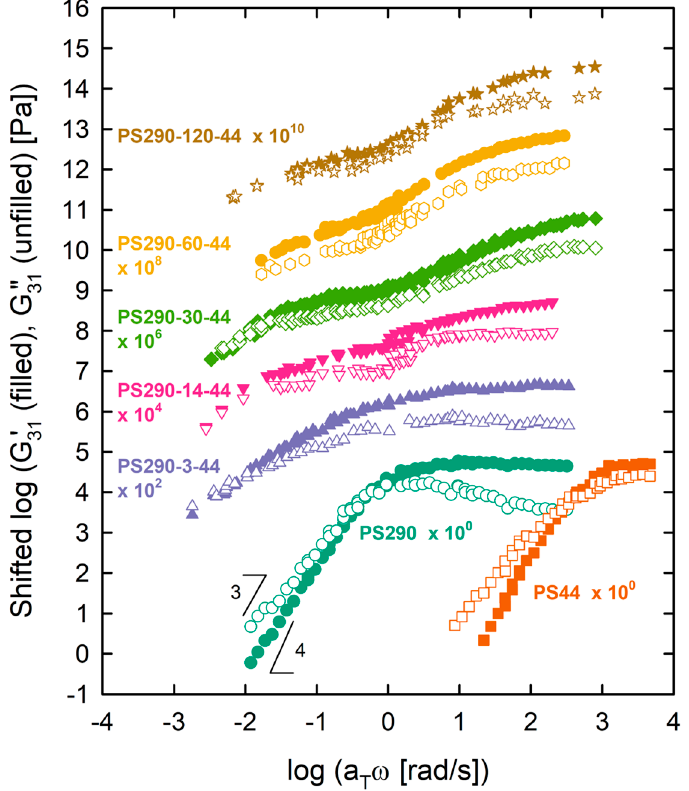
Figure 5. First-harmonic medium amplitude oscillatory shear (MAOS) moduli ( 𝐺 (cid:2871)(cid:2869) (cid:4593) and 𝐺 (cid:2871)(cid:2869) (cid:4593)(cid:4593) ) of model comb PS set at T ref = 180 °C. All values are negative. Moduli were shifted vertically for clarity of presentation.